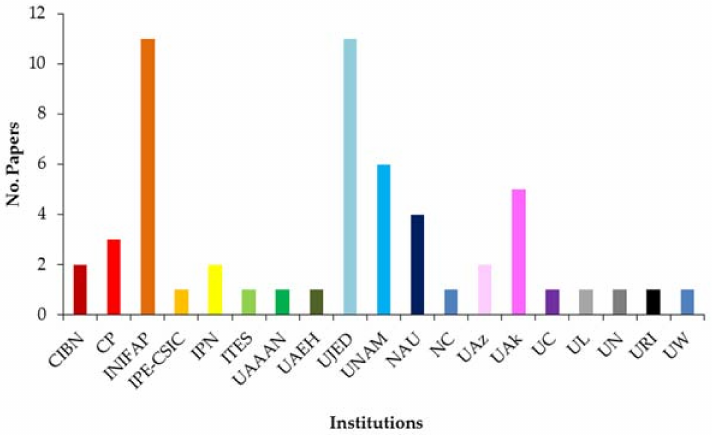
Figure 11. Research centers in which work is carried out around dendrochronological issues in Mexico estimated according to the first author of the study). The abbreviations are: National Center of